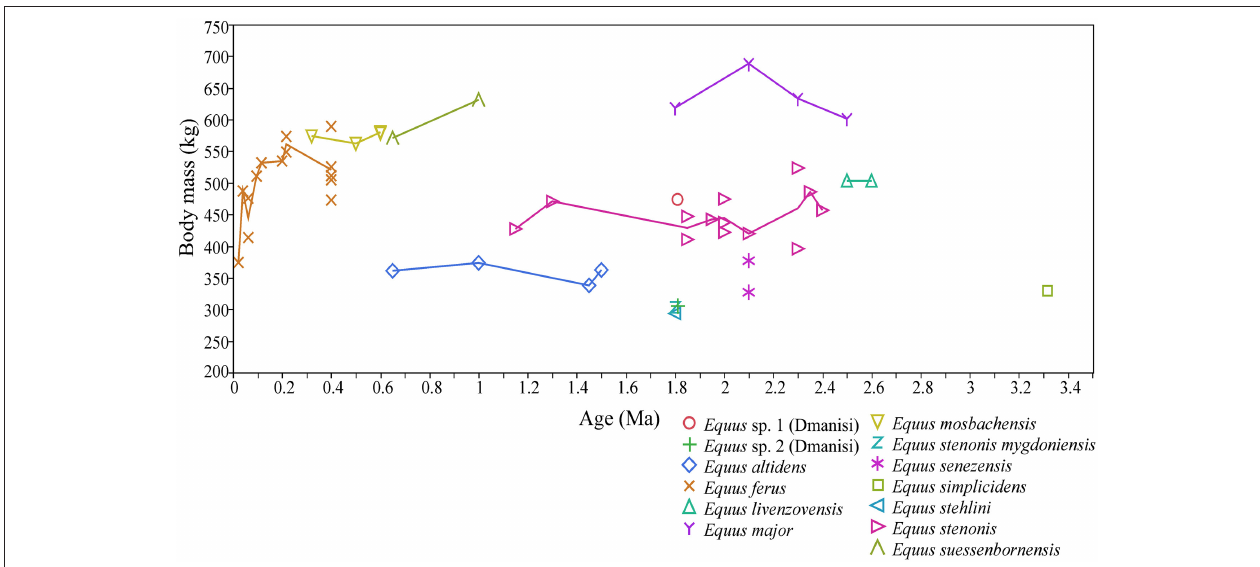
FIGURE 5 | Body mass of Equus sp. in Europe during the Pleistocene, and the earliest Equus from the Hagerman Horse Quarry, (Idaho, USA). The body mass estimates are based on mid-shaft widths, proximal widths and distal widths of metacarpals and metatarsals III, using the equations of Scott (1990). These are the preferred estimators of Equus body mass due to their high accuracy in the mass estimation of modern zebras, and their commonness and abundance in the fossil